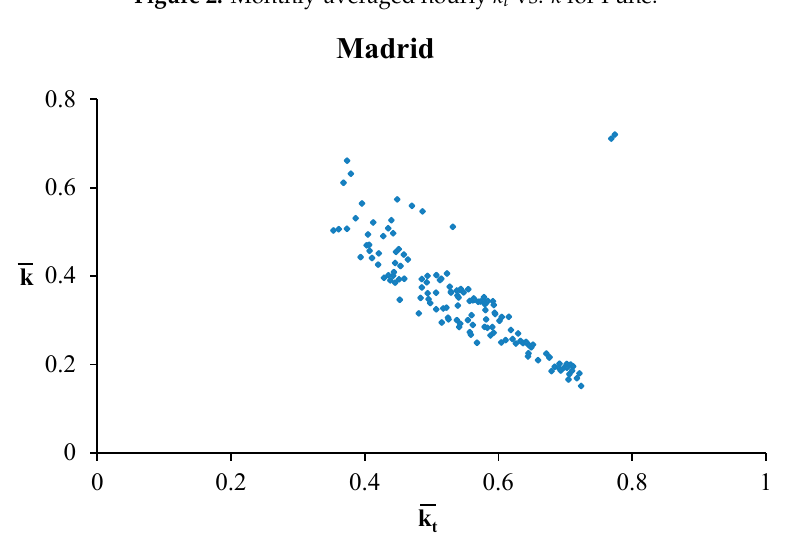
Figure 2. Monthly ‐ averaged hourly k t vs. k for Pune.